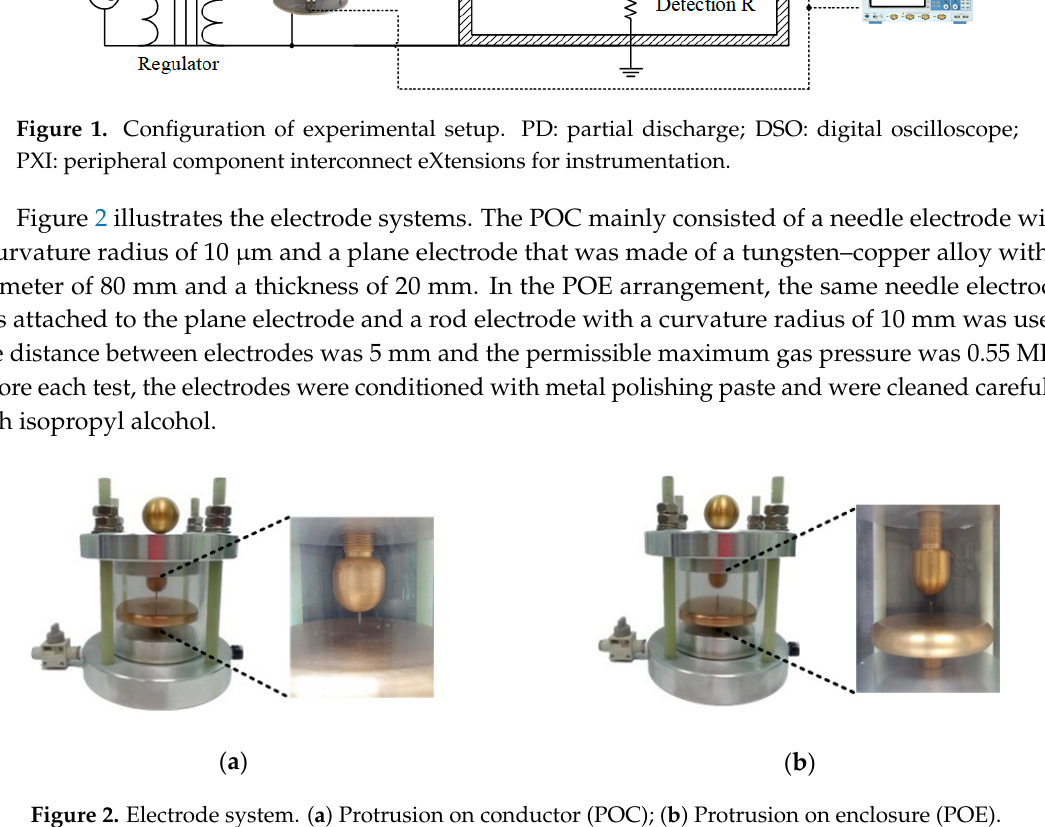
Figure 2. Electrode system. ( a ) Protrusion on conductor (POC); ( b ) Protrusion on enclosure (POE).